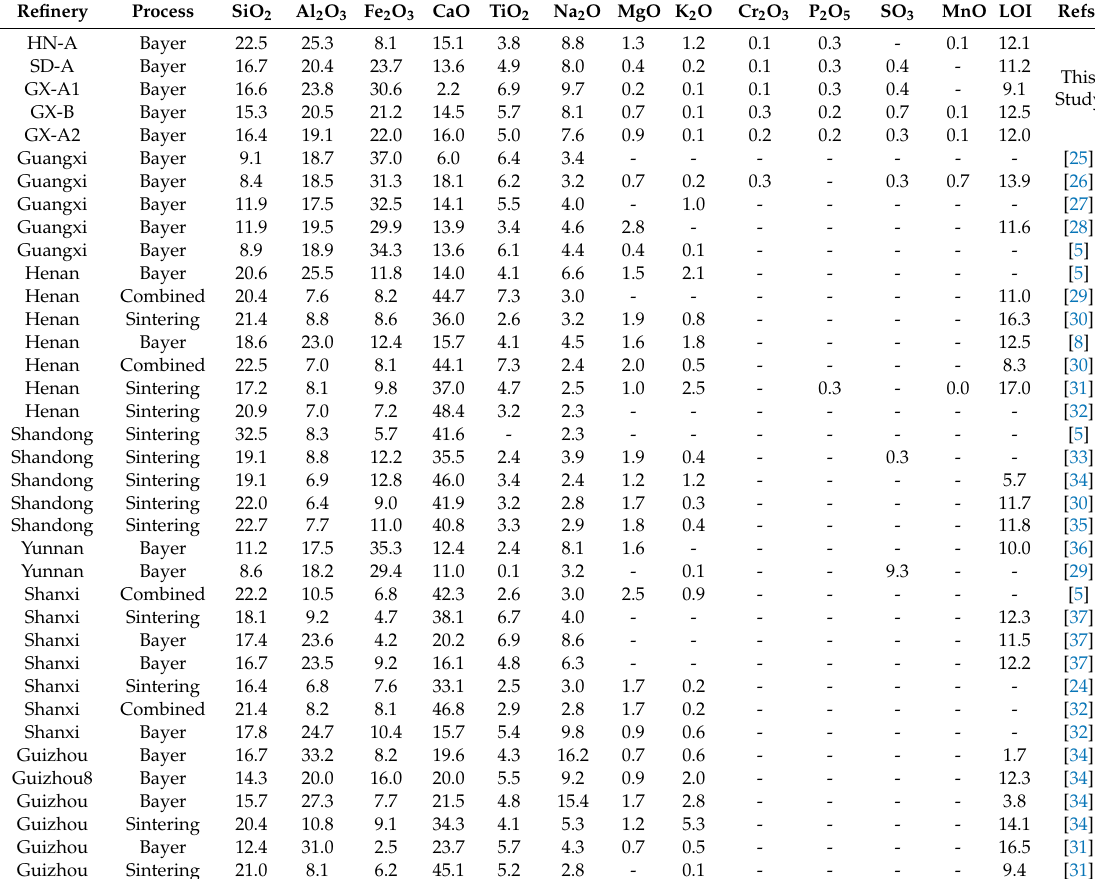
Table 3. The major chemical compositions (Oxide wt.%) of red mud in China.